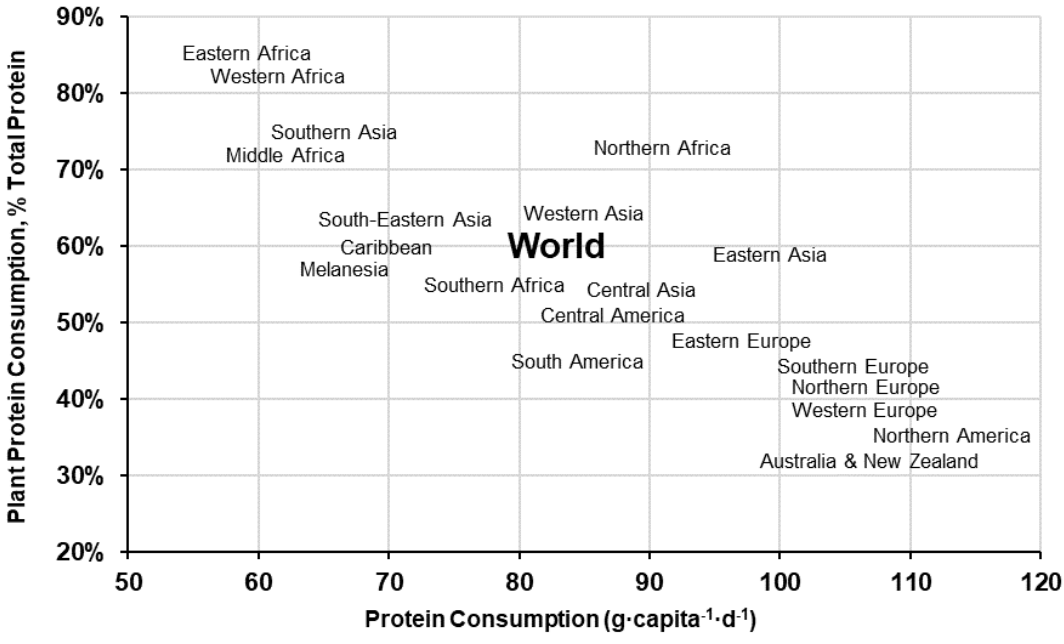
Figure 1. World and regional percent plant protein consumption and total daily protein consumption (g · capita − 1 · d − 1 ) [9].